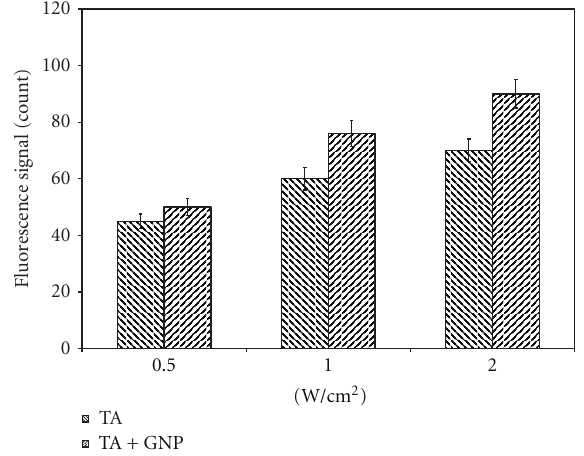
Figure 5: Recorded fluorescence signal from the TA solution without gold nanoparticles in the field of 1MHz ultrasound waves at intensities of 0.5, 1, and 2W/cm 2 in continuous and pulsed (in duty cycle of 50%) modes, excitation wavelength = 310 nm, and emission and excitation band width = 5nm.